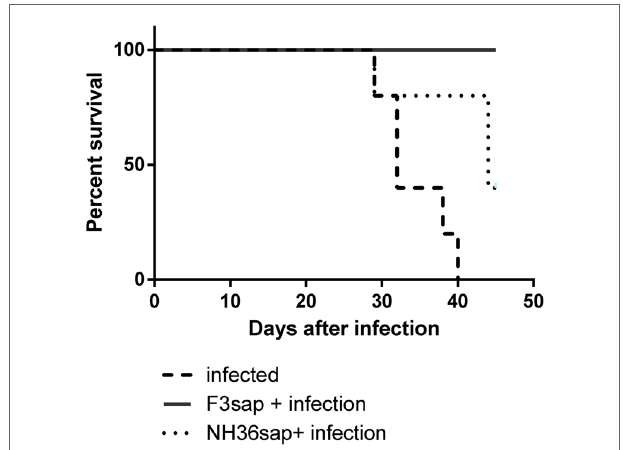
FigUre 7 | Longevity of vaccine efficacies. The survivability of infected, F3sap, and NH36sap vaccinated and infected mice were recorded and represented using a Kaplan–Meir curve. Comparison of the survival distribution of infected controls and vaccinated and challenged mice, using the Log-rank Mantel–Cox and the Gehan–Breslow–Wilcoxon tests disclosed significant differences for the F3sap vaccine ( p = 0.0018 and p = 0.0039, respectively). Differences between controls and the NH36sap vaccine were, however, only detected by the Log-rank Mantel–Cox ( p =